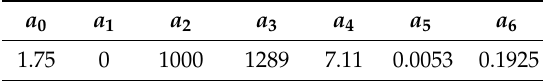
Table 1. Tire Magic Formula model